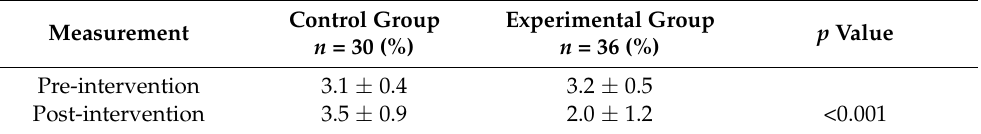
Table 3. Mean numbers of MS diagnostic criteria pre- and